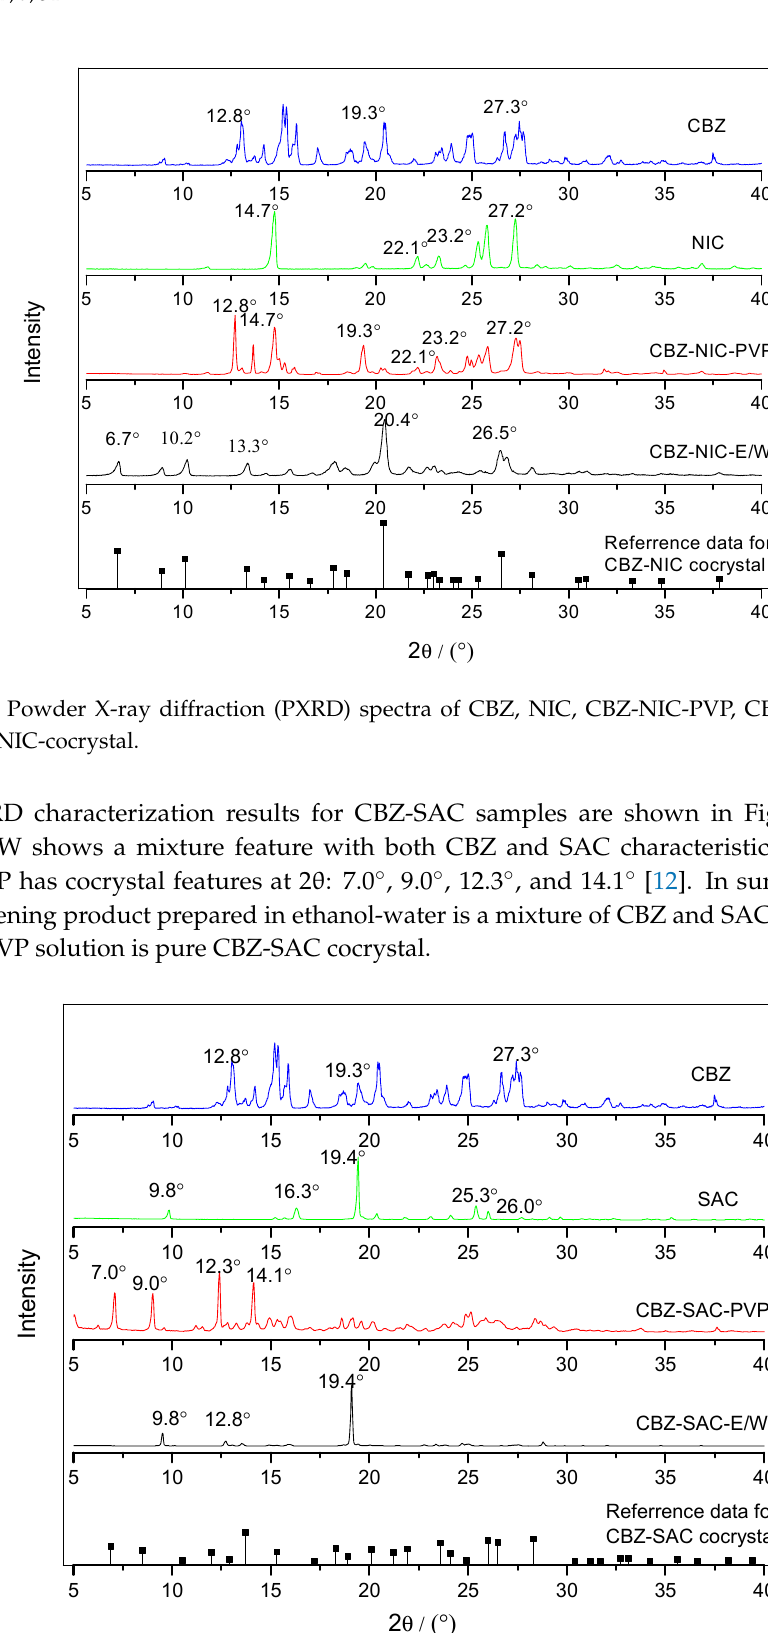
( b ) Figure 8. Illustration of the interaction between CBZ and coformer in cocrystal. ( a ) CBZ-NIC cocrystal ( b ) CBZ-SAC cocrsytal.